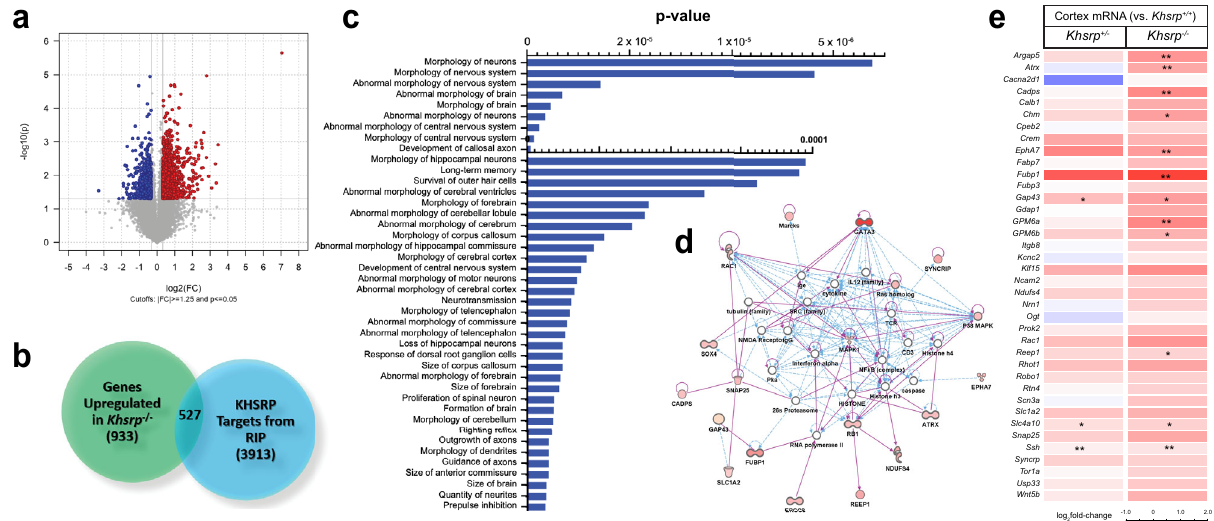
Fig. 1 Increased levels of KHSRP-target mRNAs in the neocortex of KHSRP de fi cient mice. a Volcano Plot for differential expression of mRNAs in neocortex of Khsrp − / − vs. Khsrp + / + mice from microarray analyses. The vertical gray line corresponds to log 2 fold-change (1.25 up or down), and the horizontal line represents a p-value of 0.05 that was used as a cut off for subsequent analyses. Also see Supplementary Data 1. b Venn diagram for overlap between genes signi fi cantly up-regulated in Khsrp − / − vs. Khsrp + / + and those identi fi ed as binding to KHSRP by RIP-seq (log 2 fold-change > 1.4; p < 0.05). See Supplementary Data 2 for RNAs identi fi ed by KHSRP RIP-Seq and overlap with data from panel A and Supplementary Data 3 for ARE-containing KHSRP-target mRNAs). c IPA analyses of functional pathways regulated shapes by the 527 KHSRP-target mRNAs from b reveal top pathways related to neuronal morphology. P-values were calculated by comparing the frequency of the 527 genes in each pathway with the frequency expected by chance from all the genes in the genome using Fisher ’ s exact test at the right tail. d Top nervous system development and function network identi fi ed by IPA. Up- regulated genes are highlighted in red; color intensity is proportional to fold change increase in Khsrp − / − cortex. e RTddPCR validation of alterations in levels of KHSRP-target mRNAs from d for Khsrp + / − and Khsrp − / − vs. Khsrp + / + neocortex as a heat map based on log 2 fold-changes for indicated mRNAs. See Supplementary Fig. 2c for validation of select KHSRP-target mRNAs in hippocampus and Supplementary Data 5 and 6 for mRNA copy number from these analyses ( N ≥ 3 per condition; * p ≤ 0.05, ** p ≤ 0.01, and *** p ≤ 0.005 by two-tailed Student ’ s t-